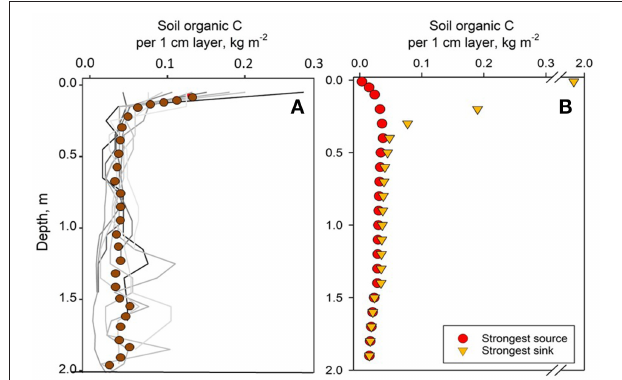
FIGURE 7 | Observed (A) and modeled (B) depth distributions of soil organic C (SOC) at depositional settings in the Calhoun Critical Zone Observatory, a warm temperate forest in South Carolina, USA. Lines in (A) represent observations in 10 profiles along a stream channel that have received eroded SOC prior to and post-European settlement at rates varying from extremely low up to ∼ 1mm y − 1 ; symbols in (A) represent a smoothed mean of all 10 profiles. Note evidence of buried, high-SOC content horizons (i.e., buried A horizons) in several observed profiles. Symbols in (B) represent model runs with contrasting assumptions about SOC production and oxidation in eroding and depositional profiles that result in varying magnitudes of land-atmosphere CO 2 fluxes. In the strongest source scenario, SOC oxidation is maximized and SOC production is minimized at eroding and depositional sites. In the strongest sink scenario, the opposite phenomena are assumed. In (A,B) , symbols represent SOC content in each 1 cm-thick layer; for clarity, not all 1 cm-thick layers are plotted. See text for model description and estimated influence of the described processes on land-atmosphere CO 2